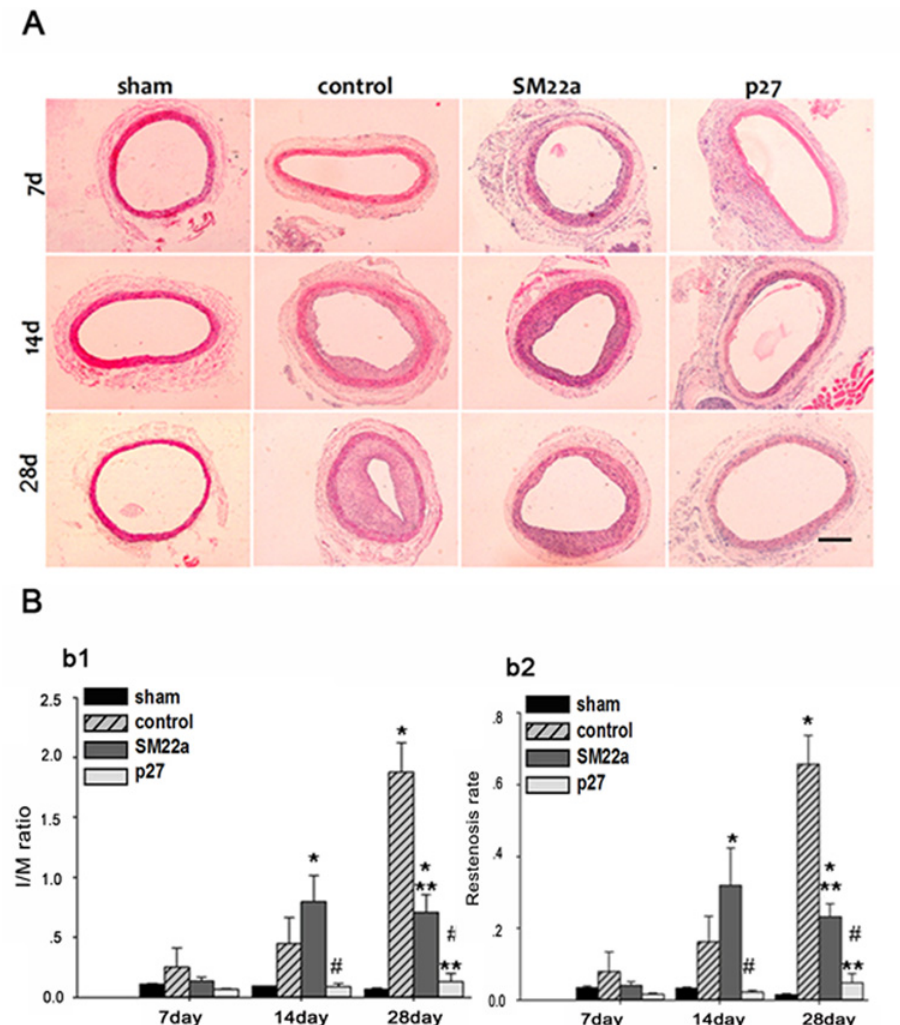
Fig 4. Targeted effect of Lenti-SM22alpha-p27 vectors in Rat Carotid Artery Balloon Injury model. A. Histological analysis of sham, control, SM22a and p27 carotid artery groups at 7, 14, and 28 days after the balloon injury. Bar: 500 μ m. B. Intima/Media ratio (b1) and Restenosis ratio (b2) of different groups. * (p < 0.05, 14 days SM22a vs. sham, 28 days control vs. sham and SM22a vs. sham). ** (p < 0.05, 28 days SM22a vs. control, p27 vs. control). #(p < 0.05, 14 days p27 vs. SM22a, 28 days p27 vs. SM22a). Error bars represent the mean ± S.E. (n =